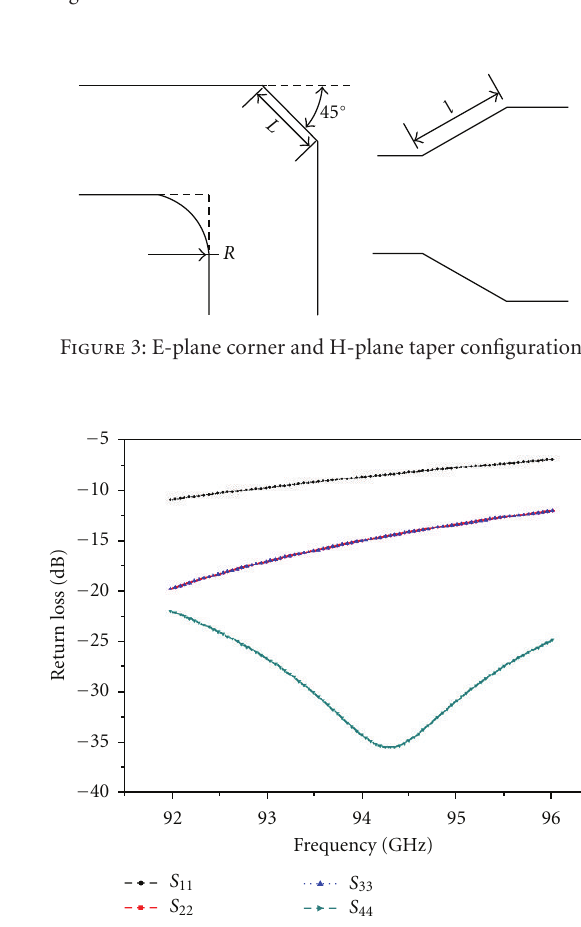
Figure 2: H-face-folded magic-T (a) geometry (b) parameters configuration.